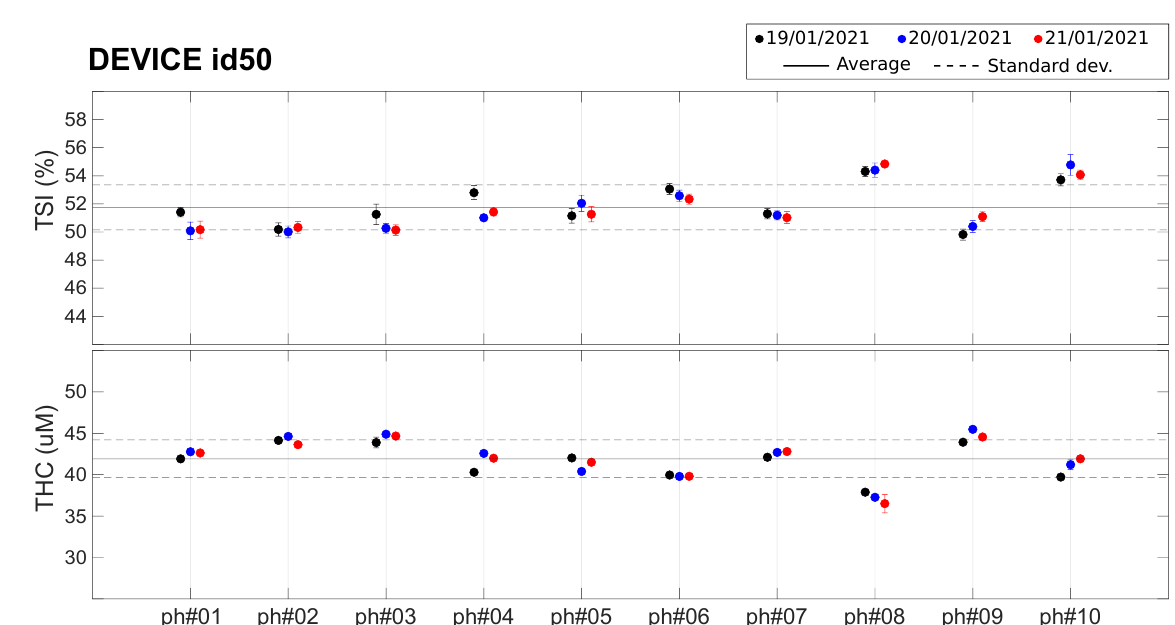
Figure 5. Set of 10 Type 2 phantoms measured with device id50. Horizontal lines represent the average (solid line) ± standard deviation (dashed lines) over all the phantoms. See text for